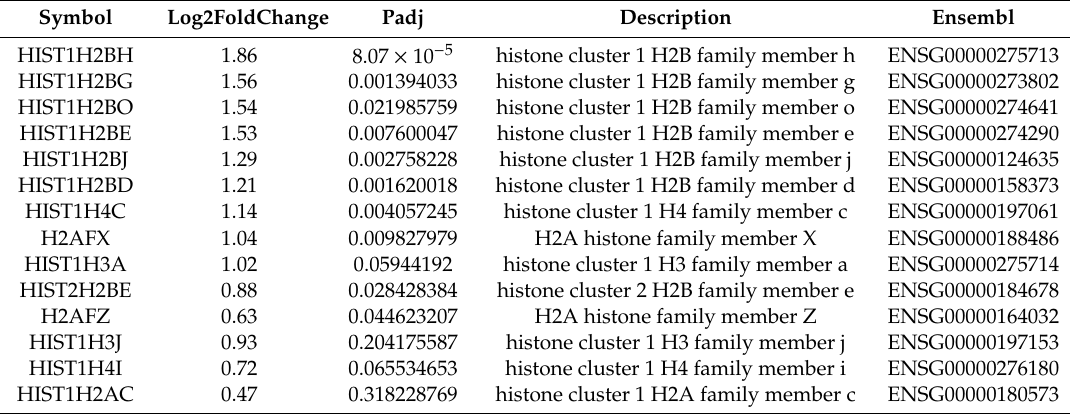
Table 1. ClusterofhistoneproteinDEGsbetweenMyr-treatedanduntreatedCF-patients-derivedmonocytes.